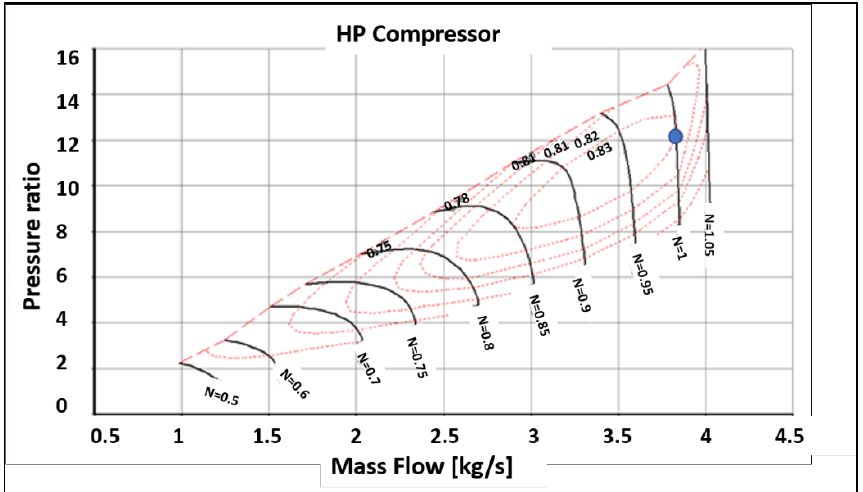
Figure 4. HP compressor map of the Engine1.